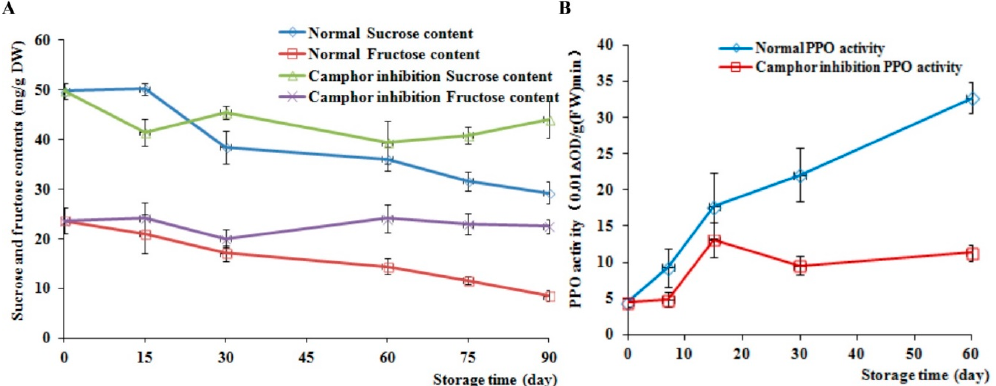
Figure 4. Effects of camphor inhibition on the sucrose and fructose contents as well as polyphenol oxidase (PPO) activity in tubers. ( A ) The contents of sucrose and fructose; ( B ) The PPO activity.